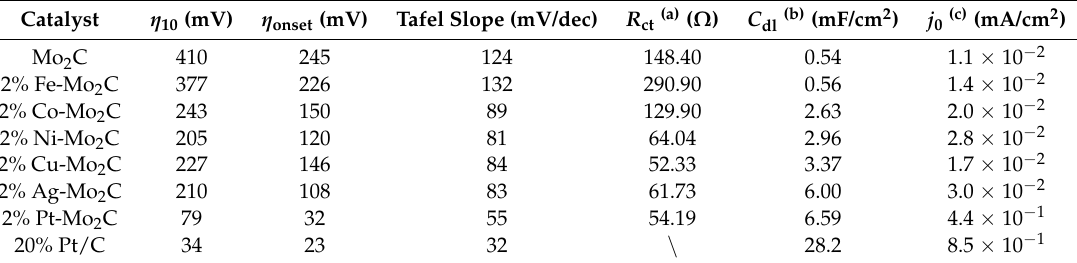
Figure 5. ( a ) Polarization curves of various metal doped molybdenum carbide catalysts and β-Mo 2 C and ( b ) Tafel plots for HER on modified with GCEs comprising various metal doped molybdenum carbides, pure β-Mo 2 C, and commercial 20% Pt/C. ( c ) Estimation of C dl by plotting the current density variation (Δ j = ( j a - j c )/2, at 150 mV versus RHE; data obtained from the CV in Figure 6) against scan rate to fit a linear regression, and ( d ) Nyquist plots (at η = 200 mV) of the above carbide electrocatalysts. Table 3. Summary of the HER activity of pure β -Mo 2 C and various metal doped molybdenum carbide catalysts in 0.5 M H 2 SO 4 .